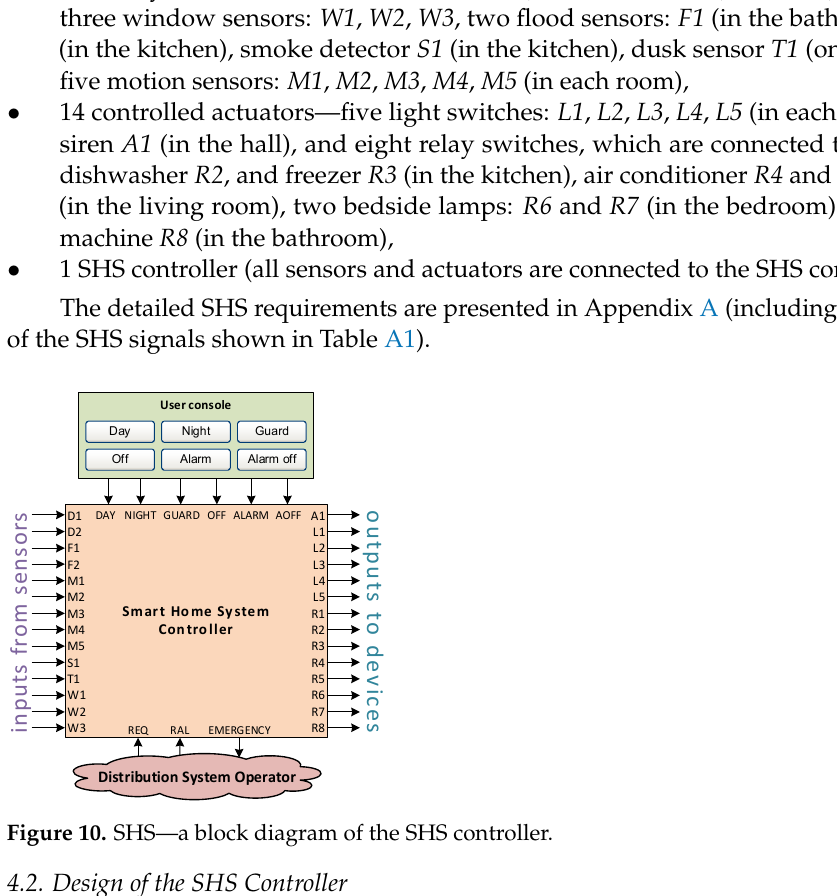
Figure 12. SHS—a UML state machine diagram on the lowest hierarchy level. The second stage is model transformation. The master FSM ( Process ) obtained after state machine decomposition can be found in Figure 13 and exemplary slave FSMs aug- mented with special signals and idle states in Figure 14. Figure 14a presents an exemplary slave FSM with implemented history mechanism (the FSM “remembers” the last active state). Finally, Figure 15 shows the obtained CFSM structure of the SHS.